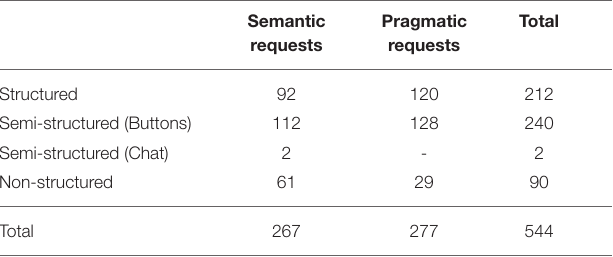
TABLE 8 | The total number of semantic and pragmatic information requests per CAVAA